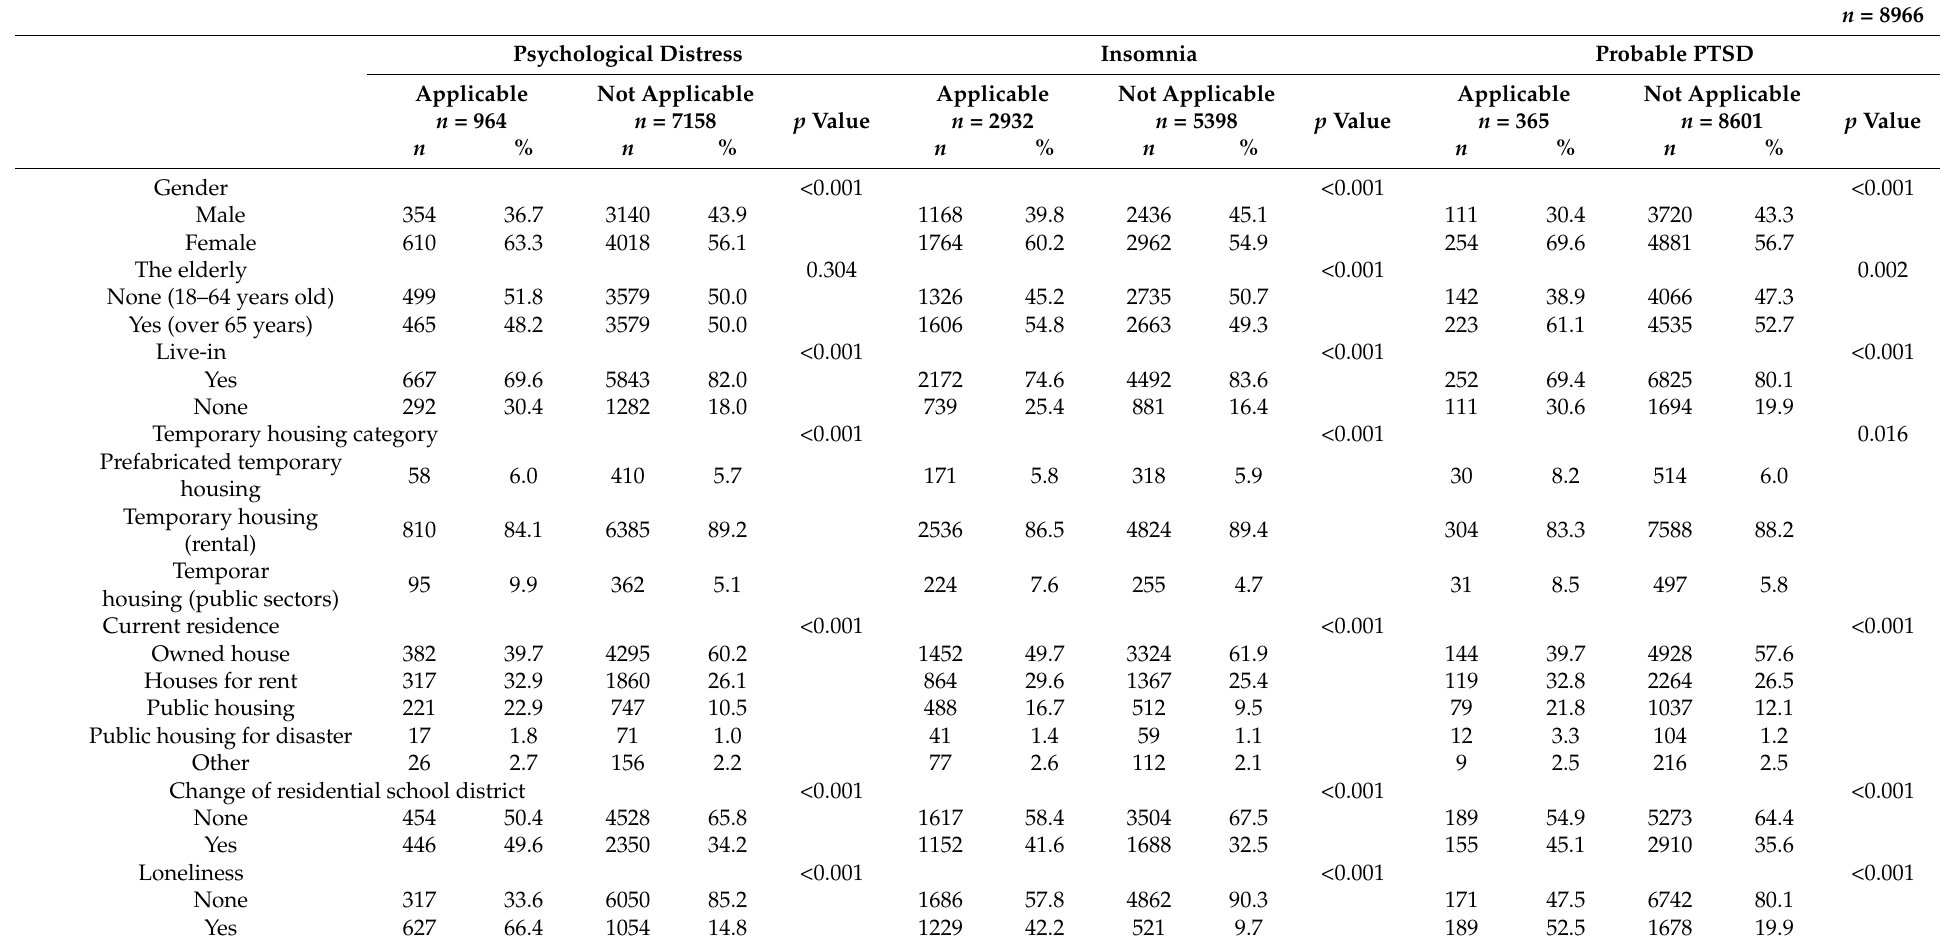
Table 3. Cross-tabulation of mental health problems and independent